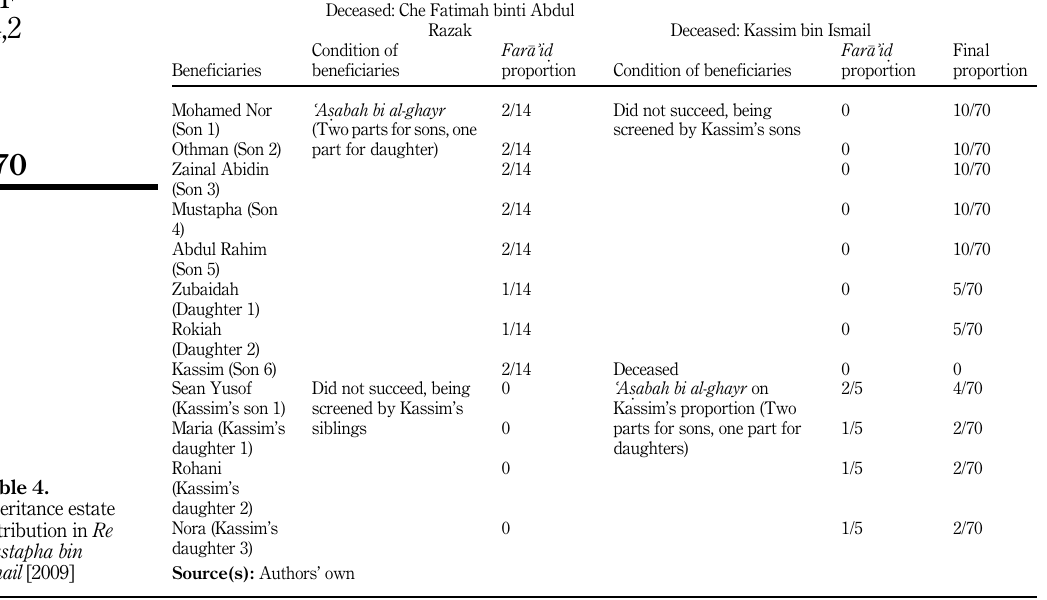
Table 4. Inheritance estate distribution in Re Mustapha bin